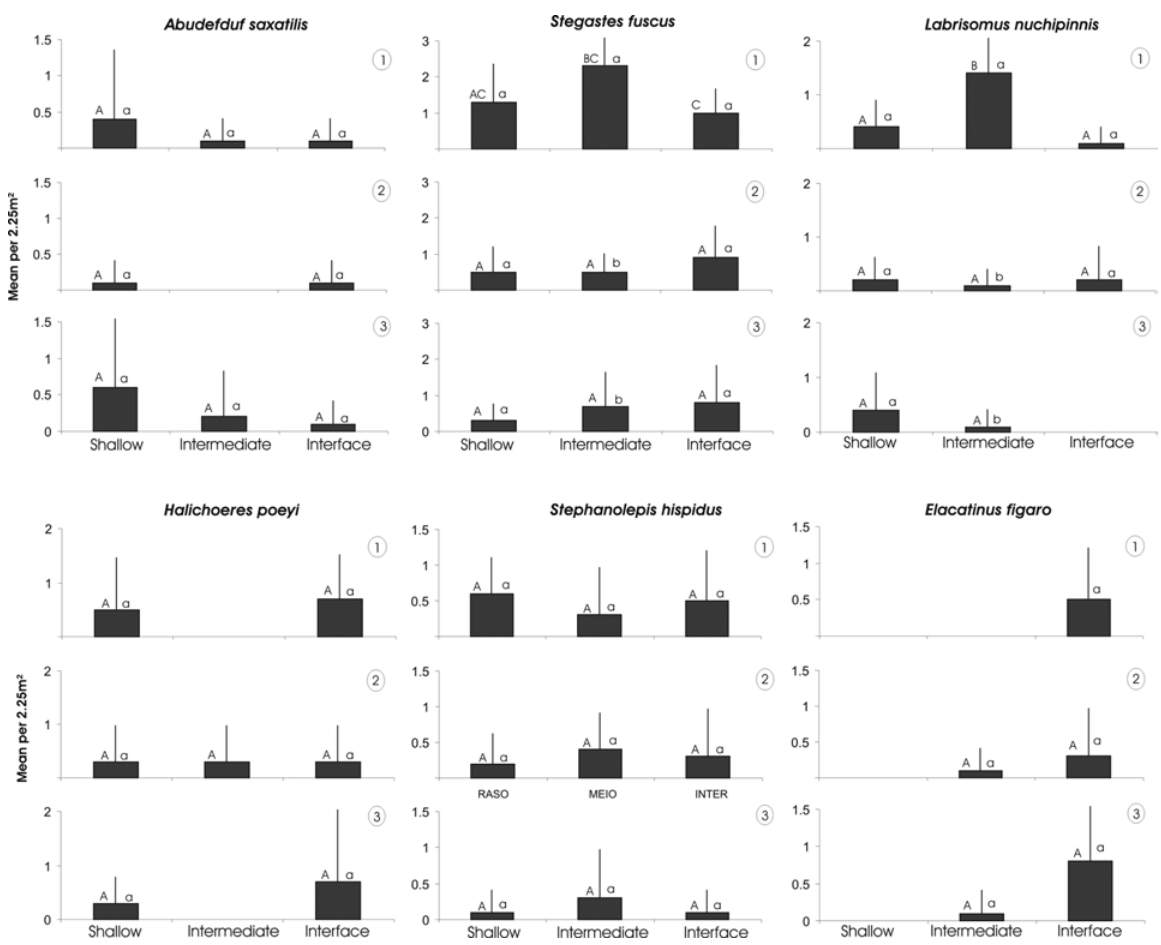
Fig. 5 – Means of density of most representative species sighted in ID patches at Maramutá reefs. Numbers in circle indicates samples (period); letters above bars indicates homogeneous groups from SNK test. Capital letters refers to comparisons depth on the same time while minuscule letters refers to comparisons depth on different